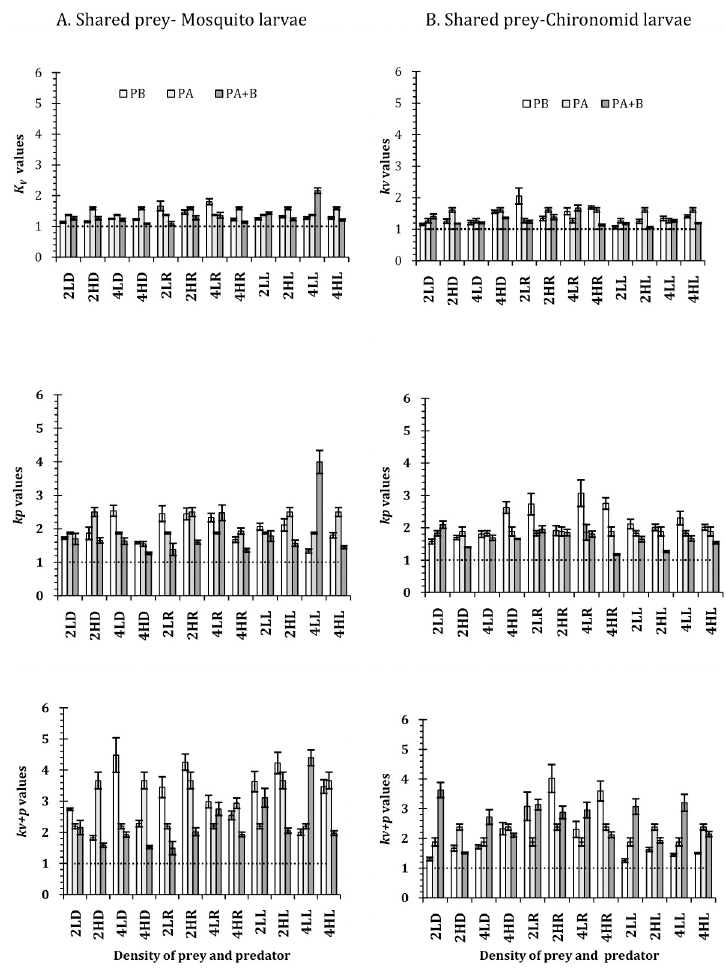
Fig 7. The ‘multiplicative risk model’ measures ( p A , p B , p A+B ) for the IGP system with different shared prey ( A. mosquito larvae and B. chironomid larvae ) in complex habitat conditions (v–vegetation, p–pebbles and v+p— vegetation and pebbles) against open conditions expressed as a ratio ( k– value, mean ± SE) for the three IG predators (S — D . rusticus , R— R . filiformis and L— L . griseus ), in two density (L– 2 individuals and H—4 individuals) under low and (50 individuals) and high (200 individuals) prey density. The dashed lines in each graph represent the reference value of 1, equivalent to the value of no difference between the complex habitat condition and open condition.